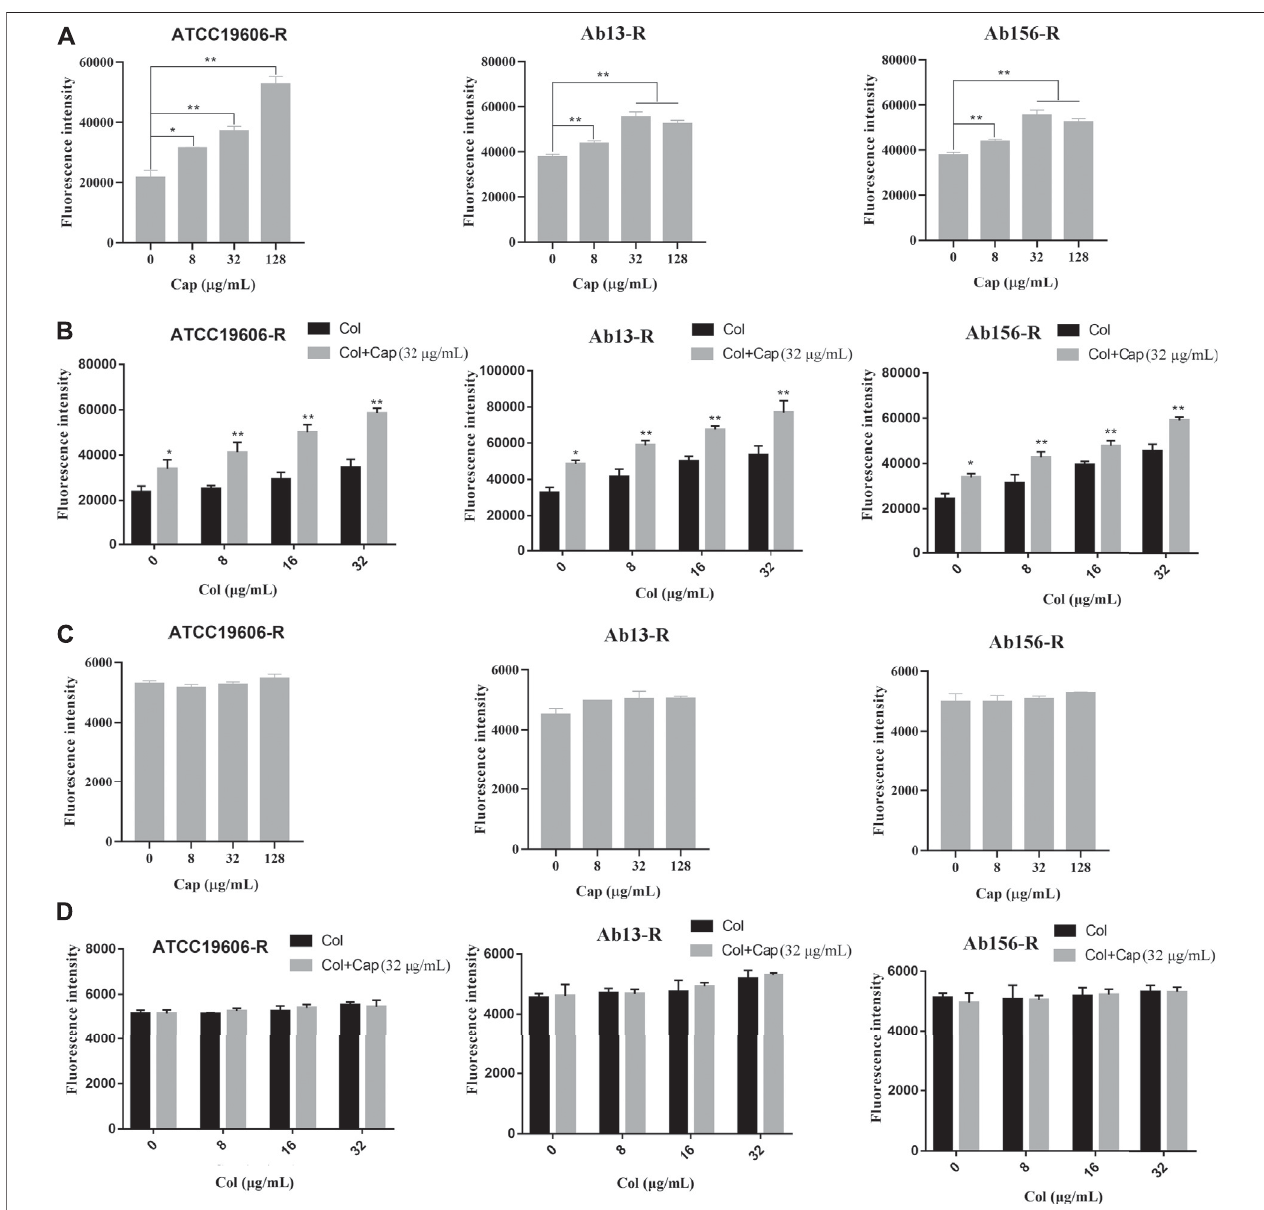
FIGURE5| Effectofcapsaicinonthepermeabilityofbacterialmembrane. (A,B) :Capsaicindisruptstheoutermembraneof A.baumannii ATCC19606-R,AB13-R and AB156-R by measuring fl uorescence intensity of 1-N-phenylnaphthylamine (NPN). (C, D) : No effect on membrane permeability for propidium iodide (PI) in A. baumannii ATCC19606-R,AB13-R and AB156-R after treatment withcapsaicin. Bacteria cellsweretreated withdifferentconcentrationsofcapsaicin (0 – 128 μ g/mL) or colistin (0 – 32 μ g/mL) without or with capsaicin (32 μ g/mL).